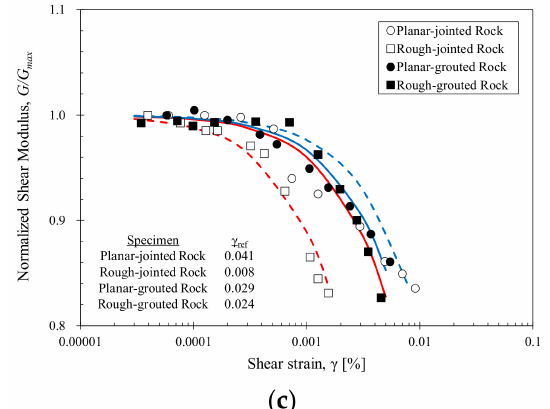
Figure 4. Stress- and strain-dependent properties of the planar-jointed rock and rough-jointed rock before and after grouting and with 7 days of curing. ( a ) Stress-dependent small-strain shear modulus for 250, 500, 750 and 1000 kPa axial stress; ( b ) Strain-dependent shear modulus at 500 kPa axial stress. The small-strain shear modulus shown in red and blue are obtained from the small-strain shear wave velocity; ( c ) Normalized shear modulus degradation curve. The data is fitted using the hyperbolic